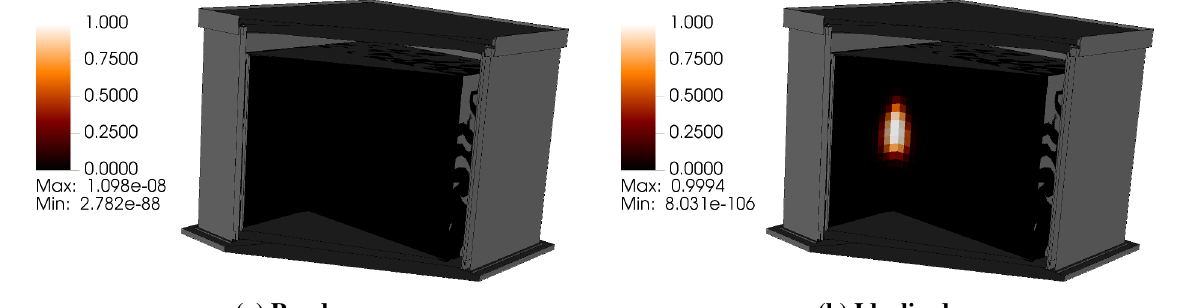
Figure 6: Image generated by VBO for hypothesis test